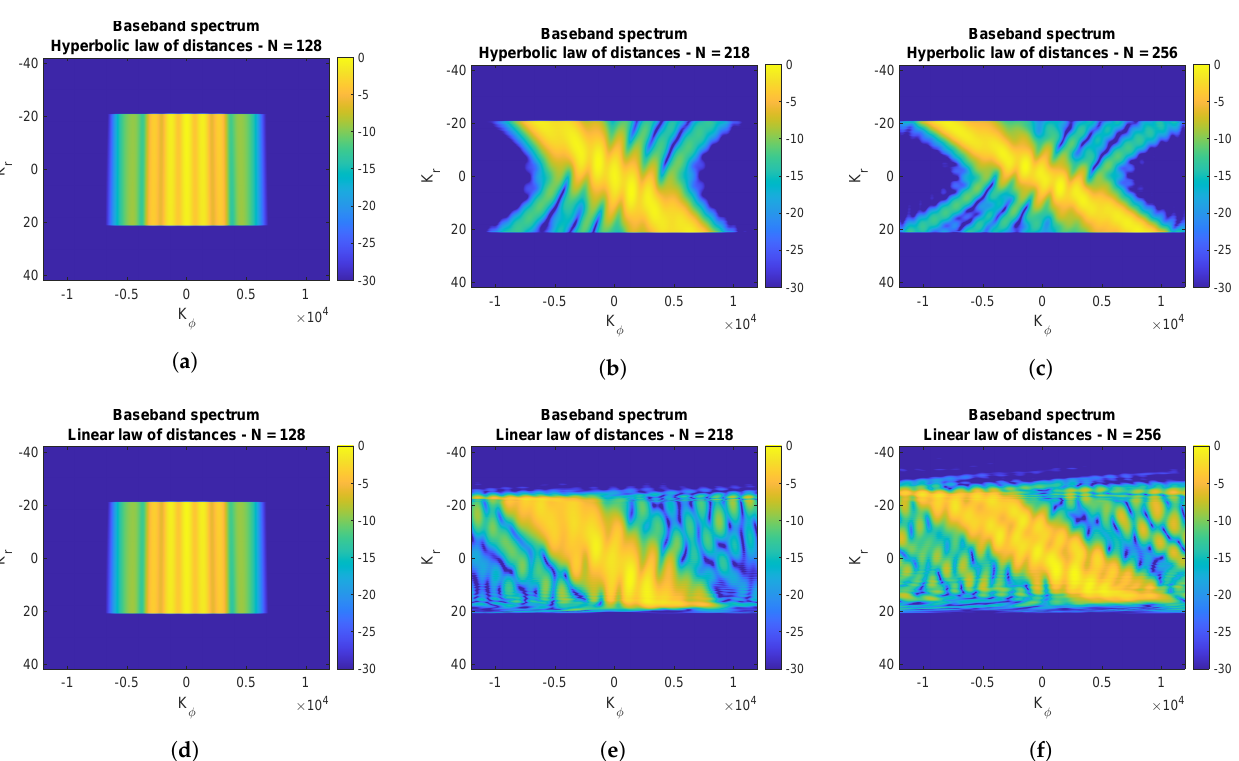
Figure 13. Baseband spectra of some low-resolution MIMO images. The row on top shows the spectra demodulated with the true (hyperbolic) law of distances. The row on the bottom shows the spectra demodulated with the approximated (linear) low of distances. In the left column, the spectra of the image in the middle of the aperture are represented. In this case, the linear approximation matches perfectly the true distance. Moving away from the center of the aperture (second and third columns), the spectra start to be more and more aliased, leading to a degradation of the final SAR image. Figure 12 provides a first quality metric for the IRF: the peak value. In Table 3, the Integrated Side Lobes Ratio (ISLR) is also depicted. The ISLR [15] is defined as: